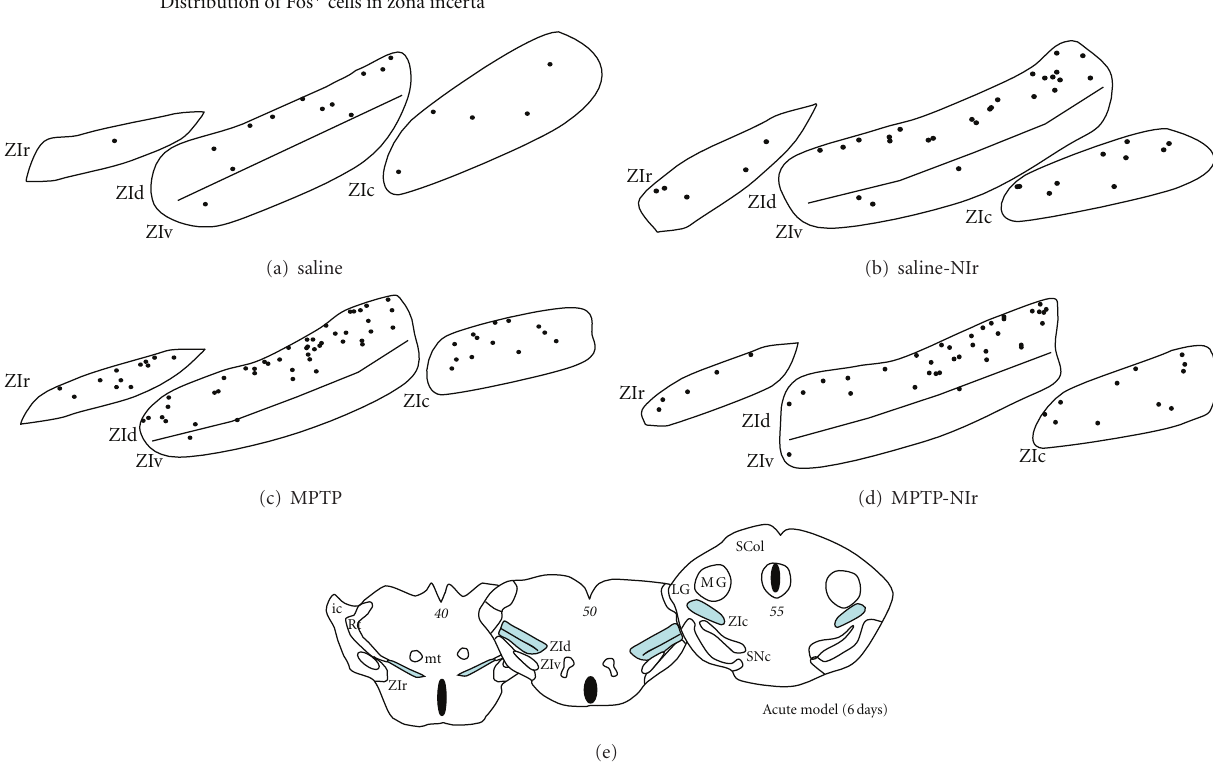
Figure 5: Schematic diagrams of the distribution of Fos + cells in the di ff erent sectors of the STN in the saline (a), saline-NIr (b), MPTP (c) and MPTP-NIr groups. These maps are from the acute model with six-day survival period (similar patterns were evident in the chronic model; in the acute model with two-hour survival period, the distribution of cells was similar to the saline cases shown here). Each black circle represents one cell. These maps were taken from coronal sections similar to the plates of the mouse atlas (numbers in italics [1]) shown in